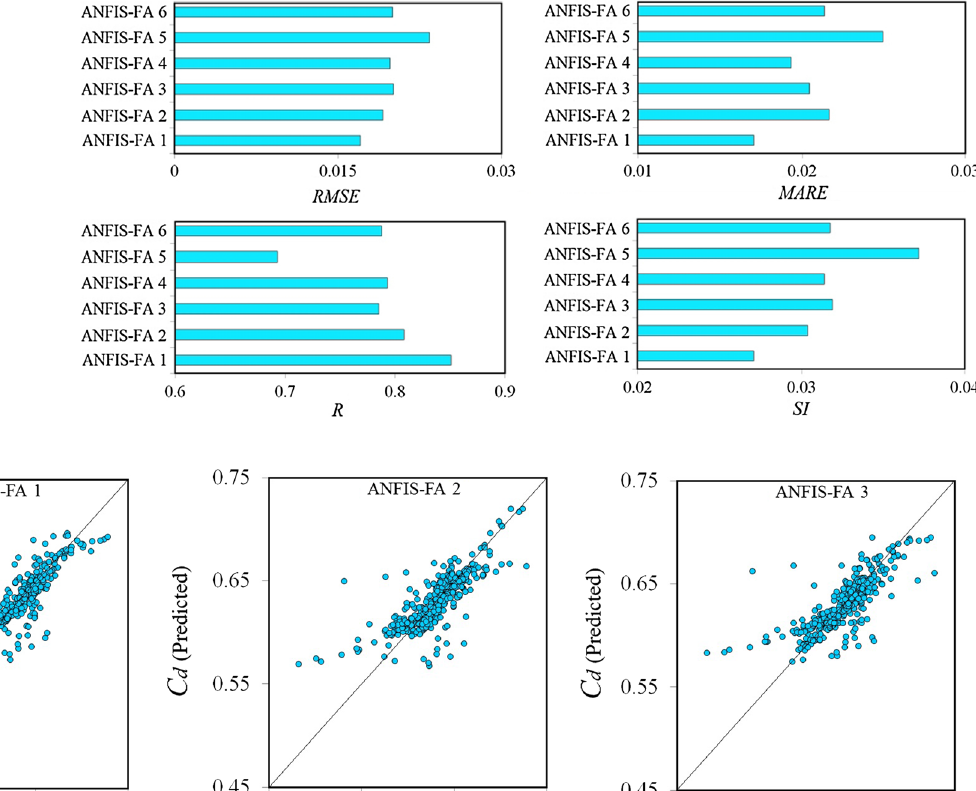
Fig. 11 Comparison of differ-